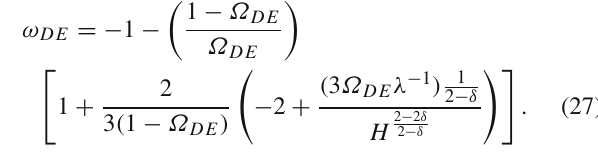
), and da attains a minima. da